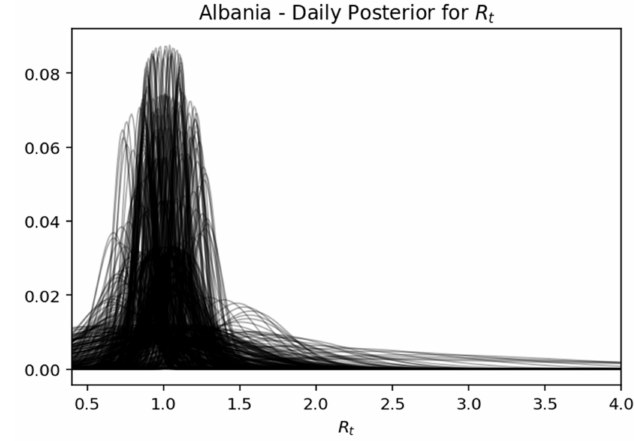
Figure 18. Albania—daily posterior for R t .